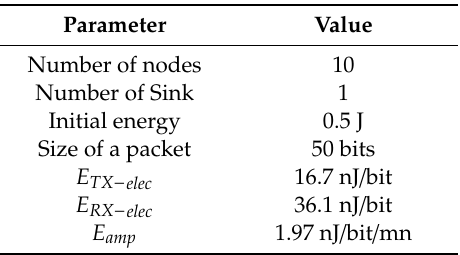
Table 1. Simulation